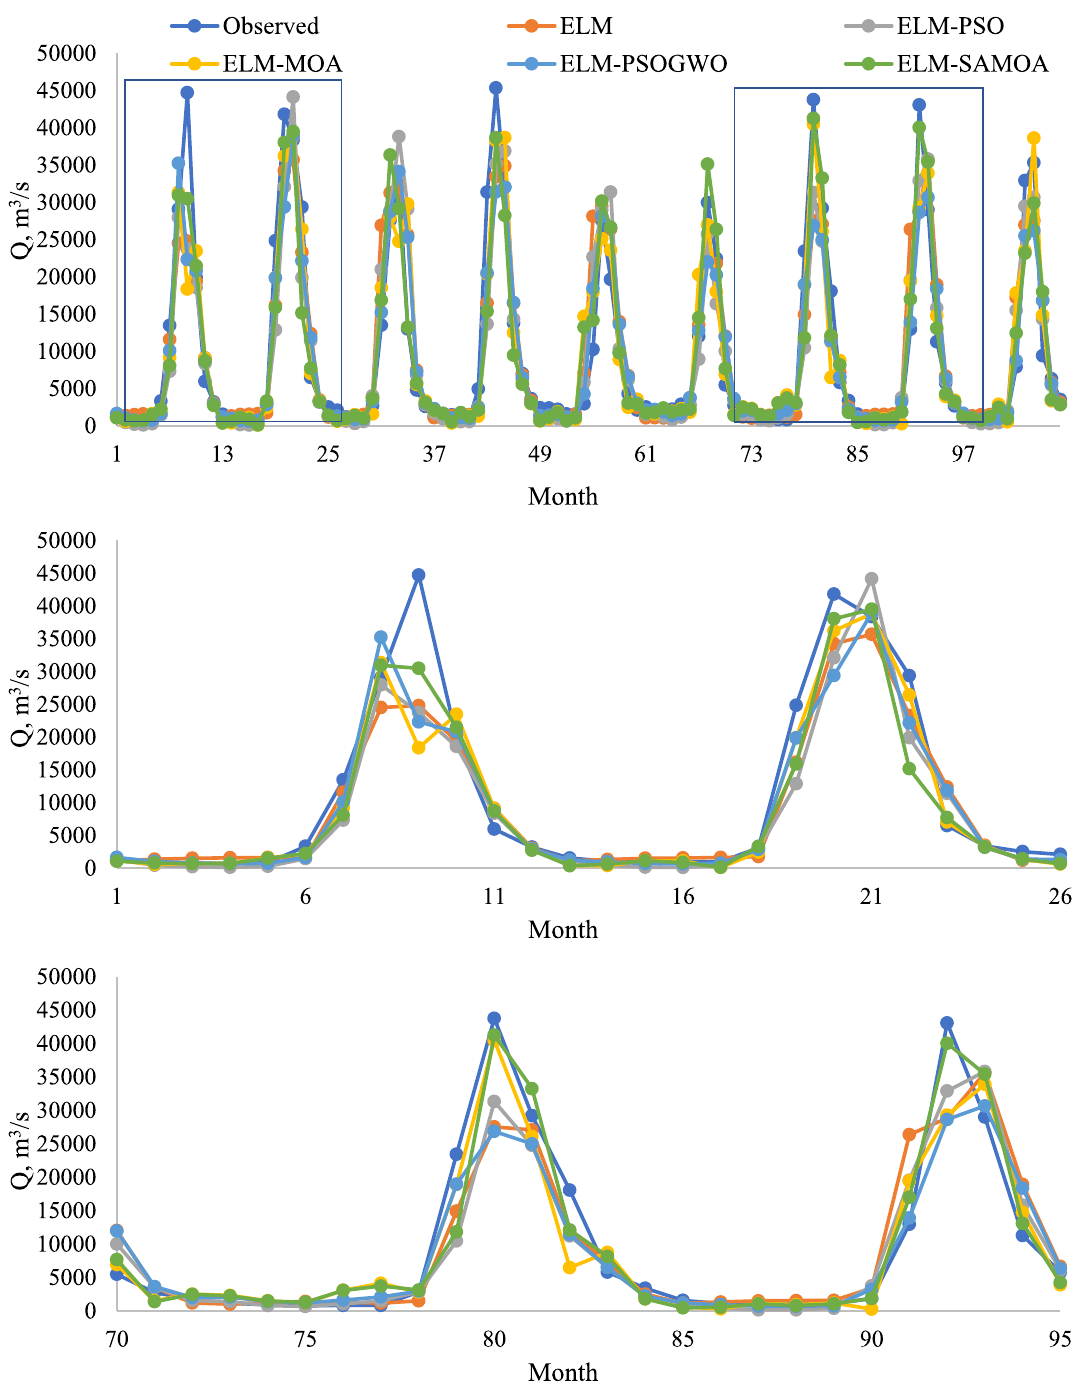
Fig. 5 Time variation graphs of the observed and predicted streamflows by different ELM-based models in the test period of Padma River Sta-